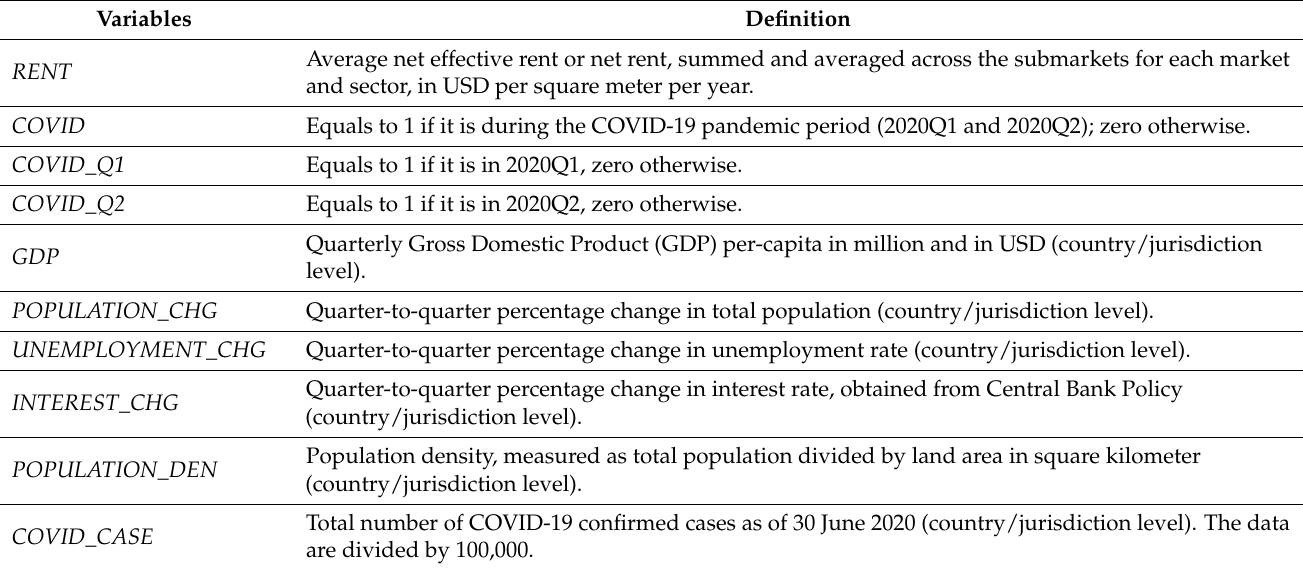
Table A1. Variables Definition. This table presents definition of the variables used in the empirical